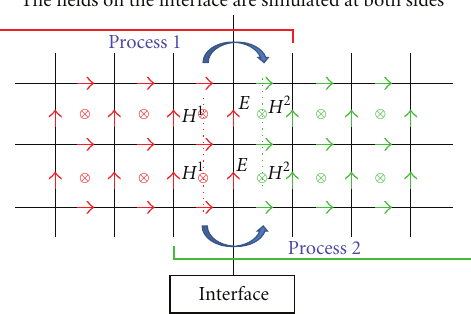
Figure 2: Concept of field exchange between the subdomains in the parallel processing.